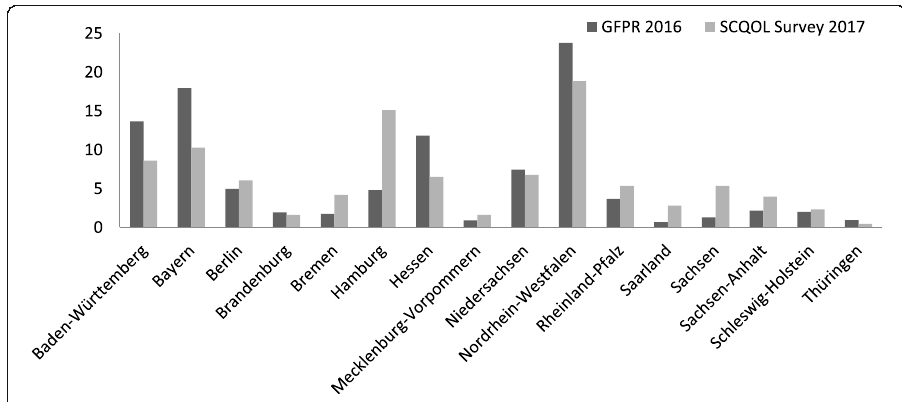
Fig. 3 Sub-Saharan African migrants ’ percentage distribution by federal state of residence in Germany for SCQOLS and GFPR